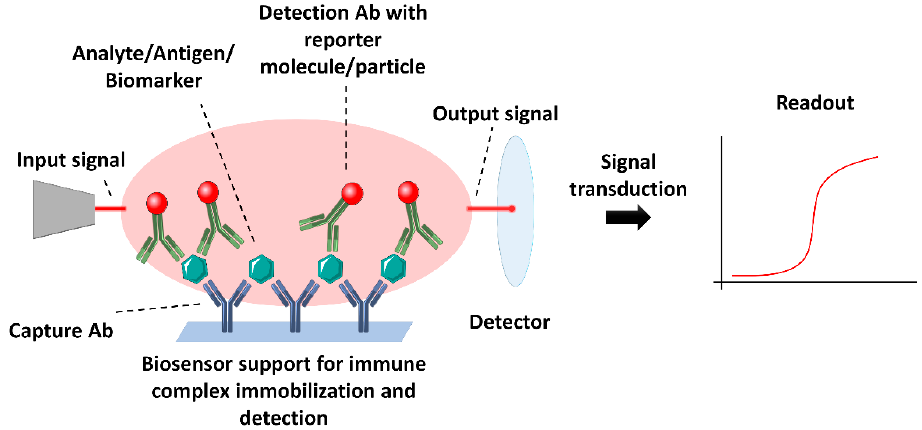
Figure 3. Schematic representation of the main components and mode of action of a